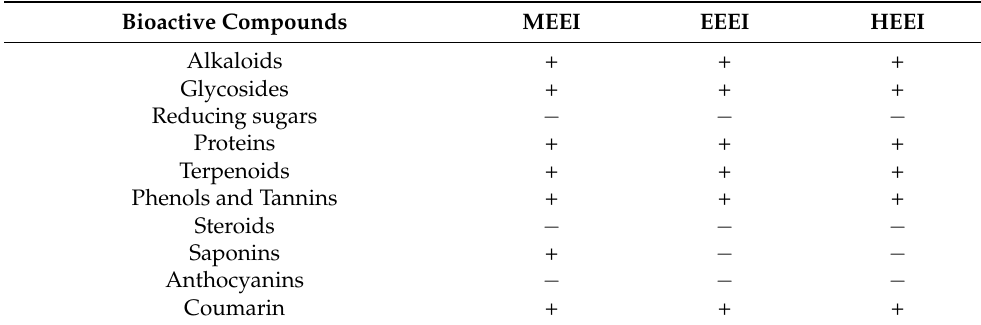
Table 1. Presence (+) or absence ( − ) of several phytochemical classes in Enteromorpha intestinalis extracts using different solvents.